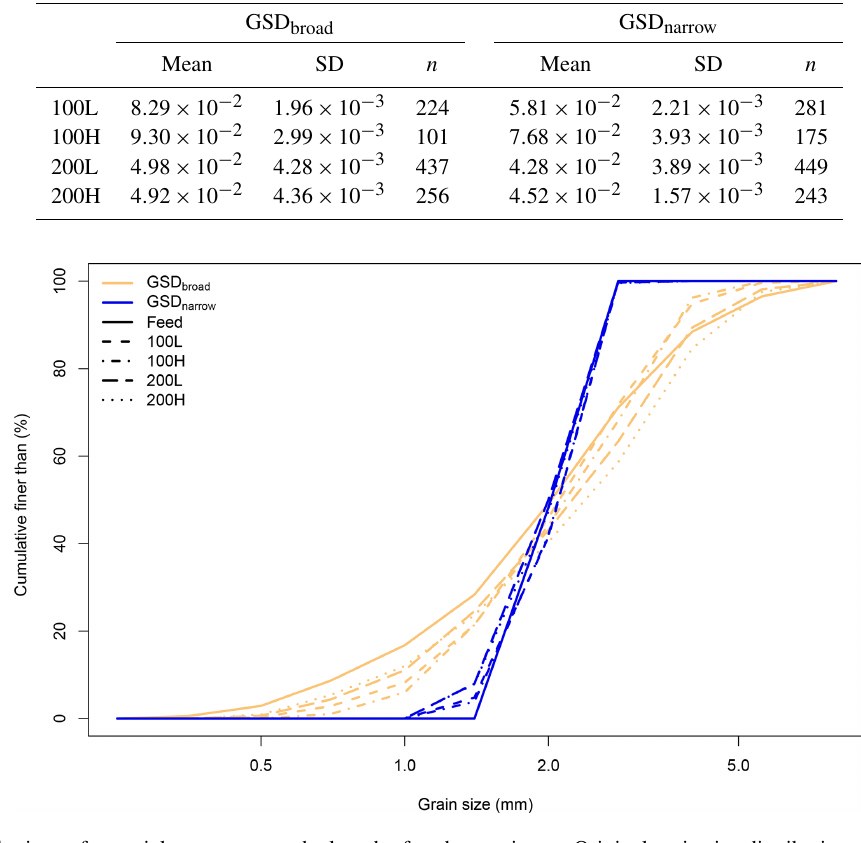
Figure 7. Size distributions of material output across the length of each experiment. Original grain size distributions are also provided.